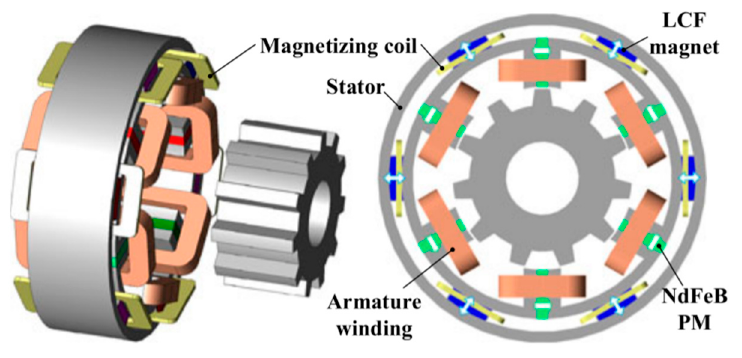
Figure 15. Topology of a FSPM memory machine [38].